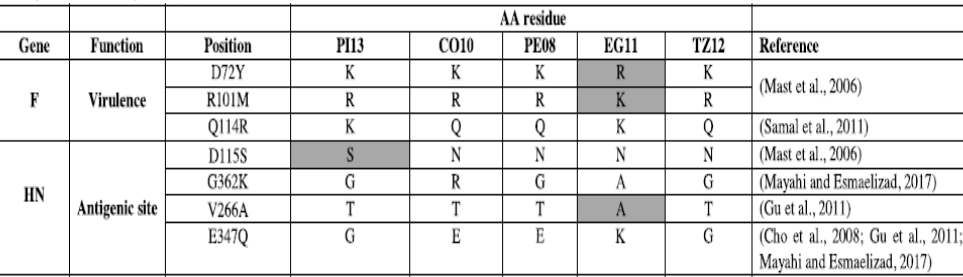
Figure 1. Amino acid changes in viruses of different genotypes. Excerpts from Ferreira, H.L.; Taylor, T.L.; Dimitrov, K.M.; Sabra, M.; Afonso, C.L.; Suarez, D.L. Virulent Newcastle disease viruses from chicken origin are more pathogenic and transmissible to chickens than viruses normally maintained in wild birds. [55].